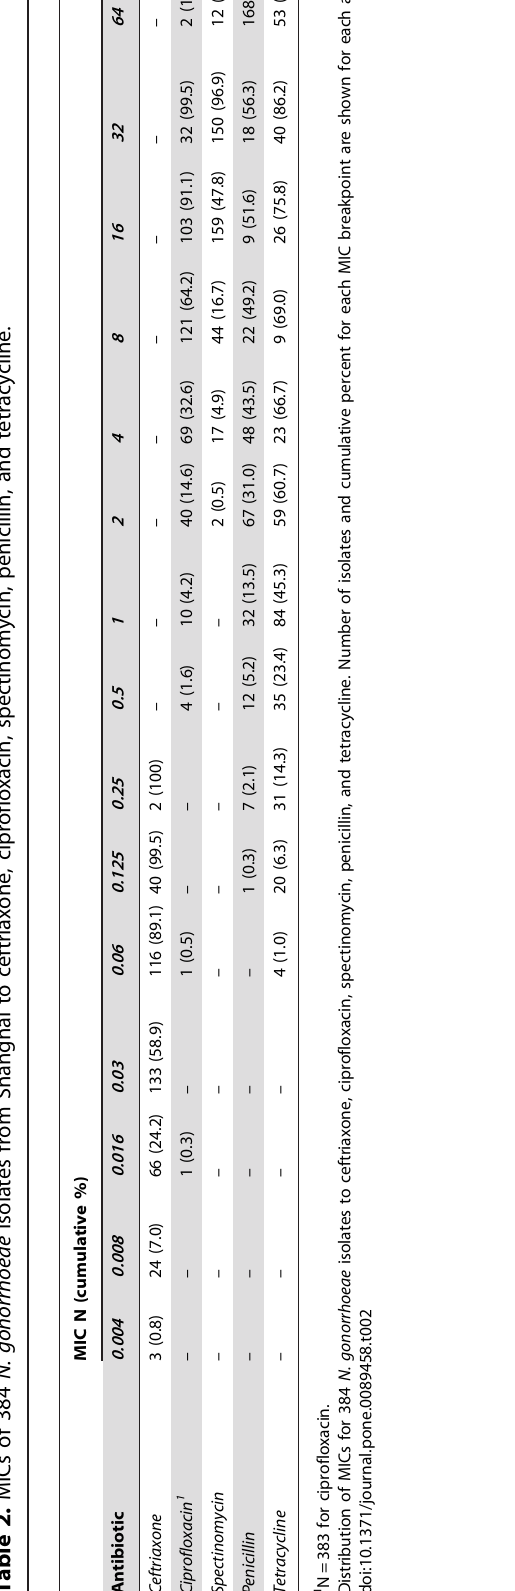
(Table S1). Final Models of Factors Associated with Reduced Susceptibility and Probable Resistance to